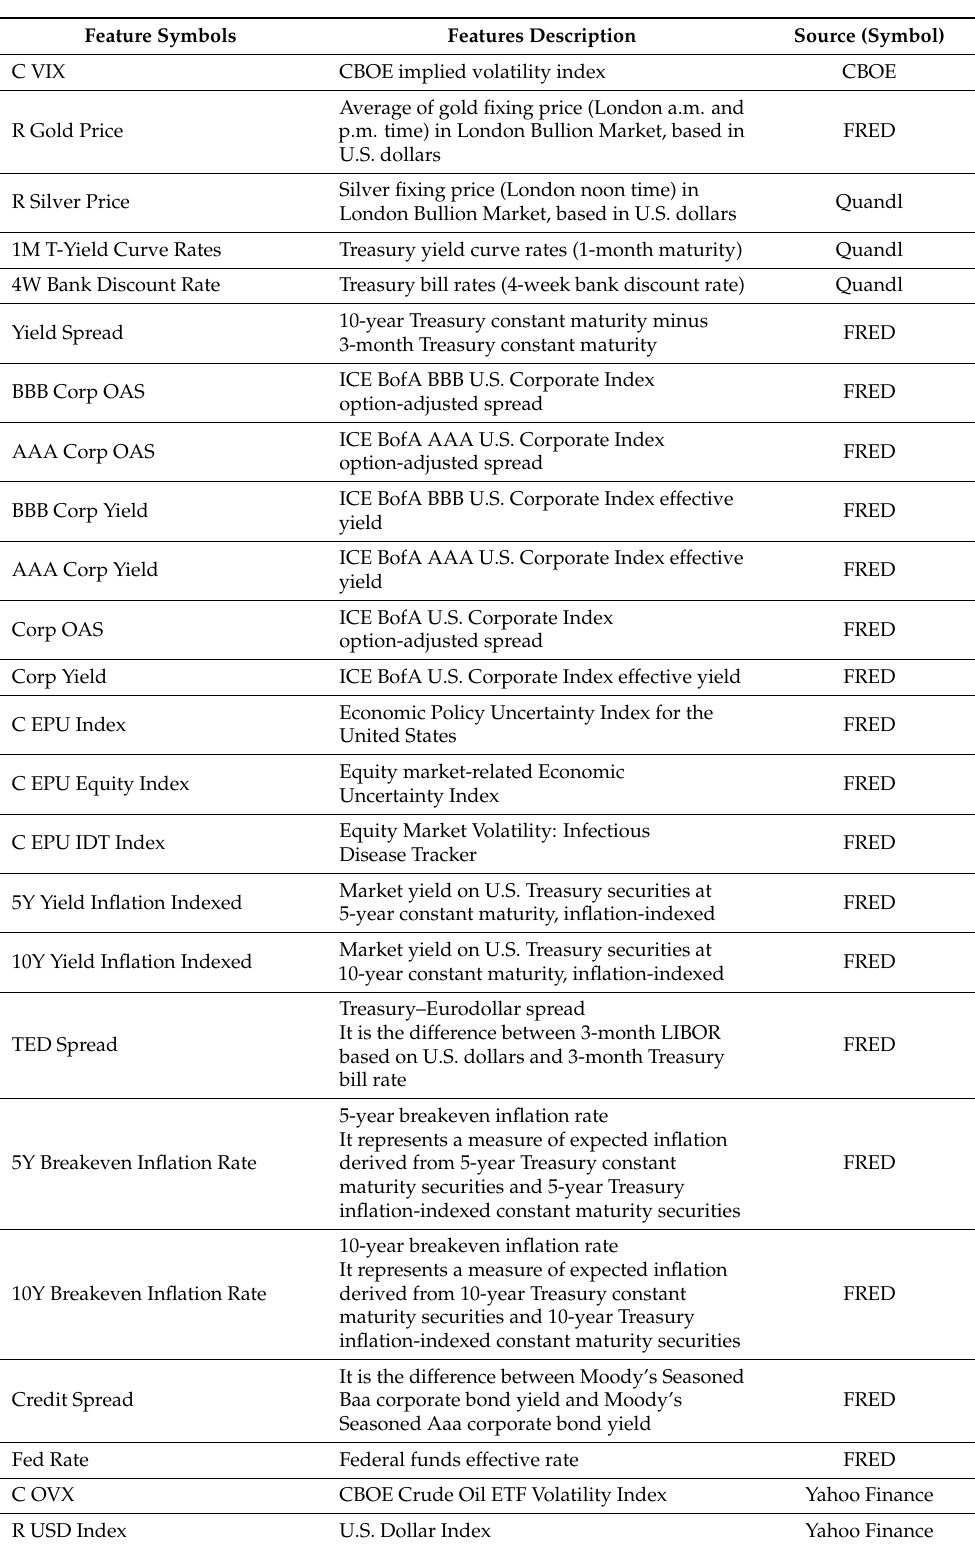
Table 1. List of daily and weekly